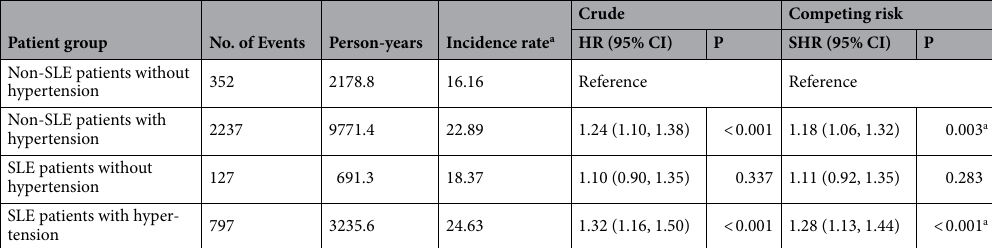
Table 5. Incidence rates and risks of AVF/AVG dysfunction SLE and non-SLE patients with and without hypertension. AVF arteriovenous fistula, AVG arteriovenous graft, SLE systemic lupus erythematosus, HR hazard ratio, SHR subdistribution hazard ratio, CI confidence interval. a Per 100 person-years.